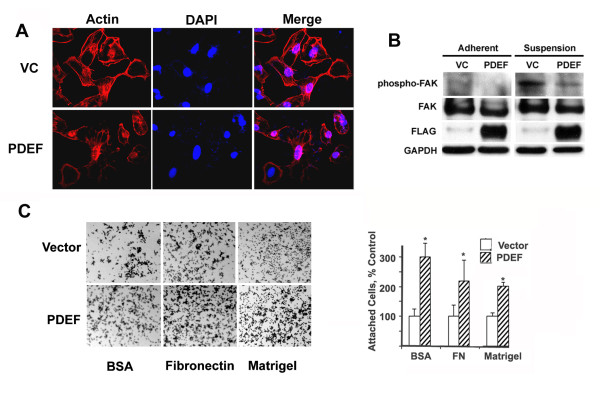
Effects of PDEF expression in prostate cancer cells on cell morphology, FAK phosphorylation and attachment to specific substrates. A, Phalloidin staining of actin cytoskeleton in PDEF expressing and vector control cells. B, Decreased phophorylation of FAK in PDEF expressing cells growing in suspension culture. C, Representative photomicrographs from experiments testing attachment of PC3 cell expressing PDEF to either BSA or fibronectin or matrigel-treated plastic surface as described in Material and Methods; and quantitation of these data. Asterisks indicate significance levels of p < 0.05 with respect to controls.